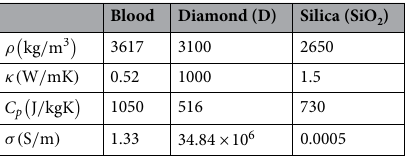
Table 1. Thermo-physical features of blood, diamond and silica 30 .